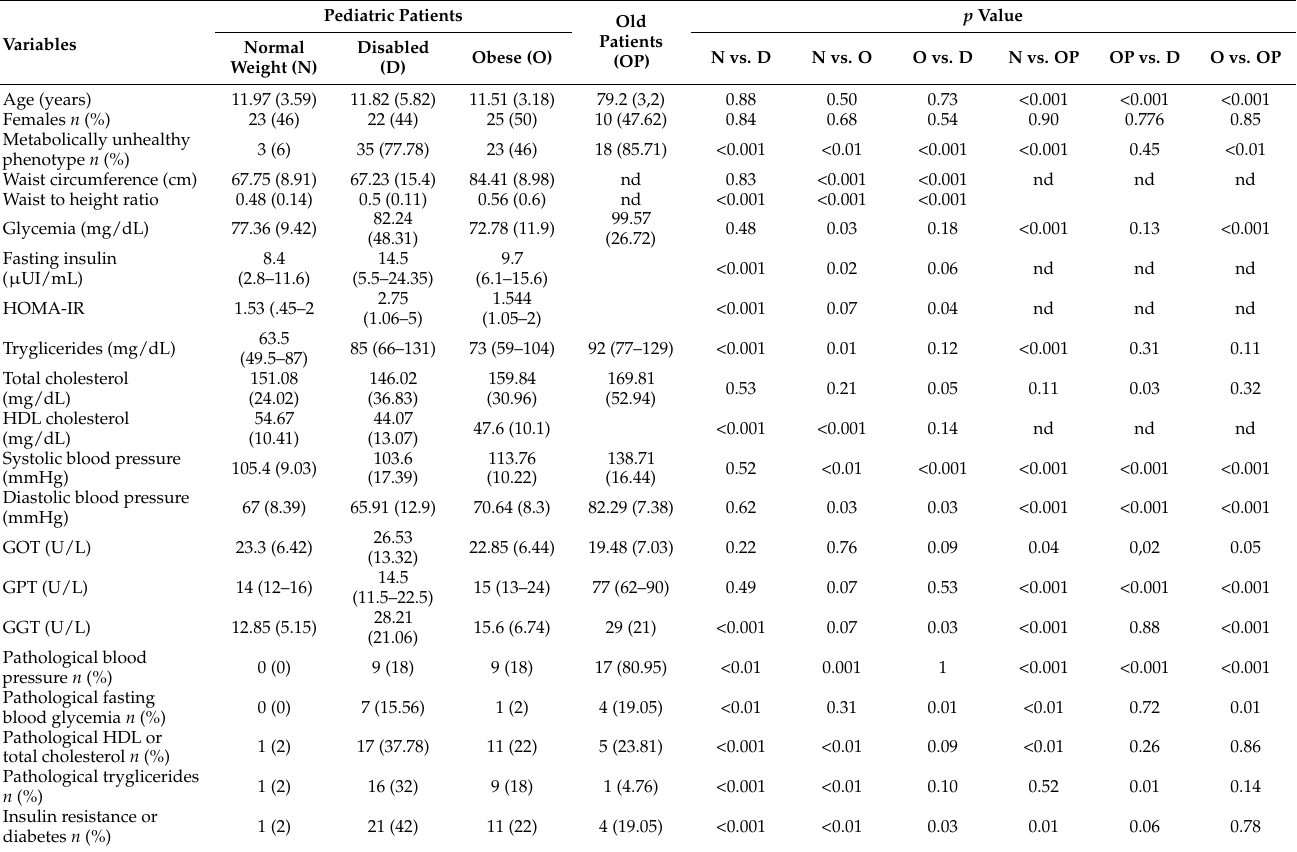
Table 1. Clinical, metabolic and cardiovascular parameters in pediatric and old